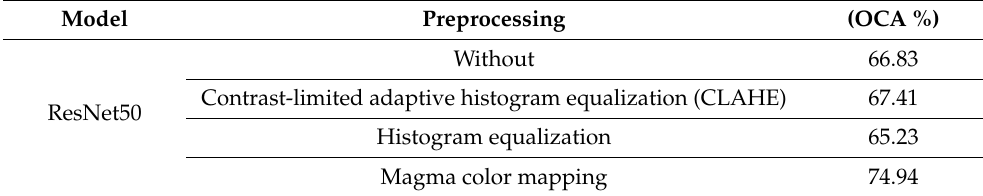
Table 4. The effect of preprocessing full mammograms on the DDSM test performance.